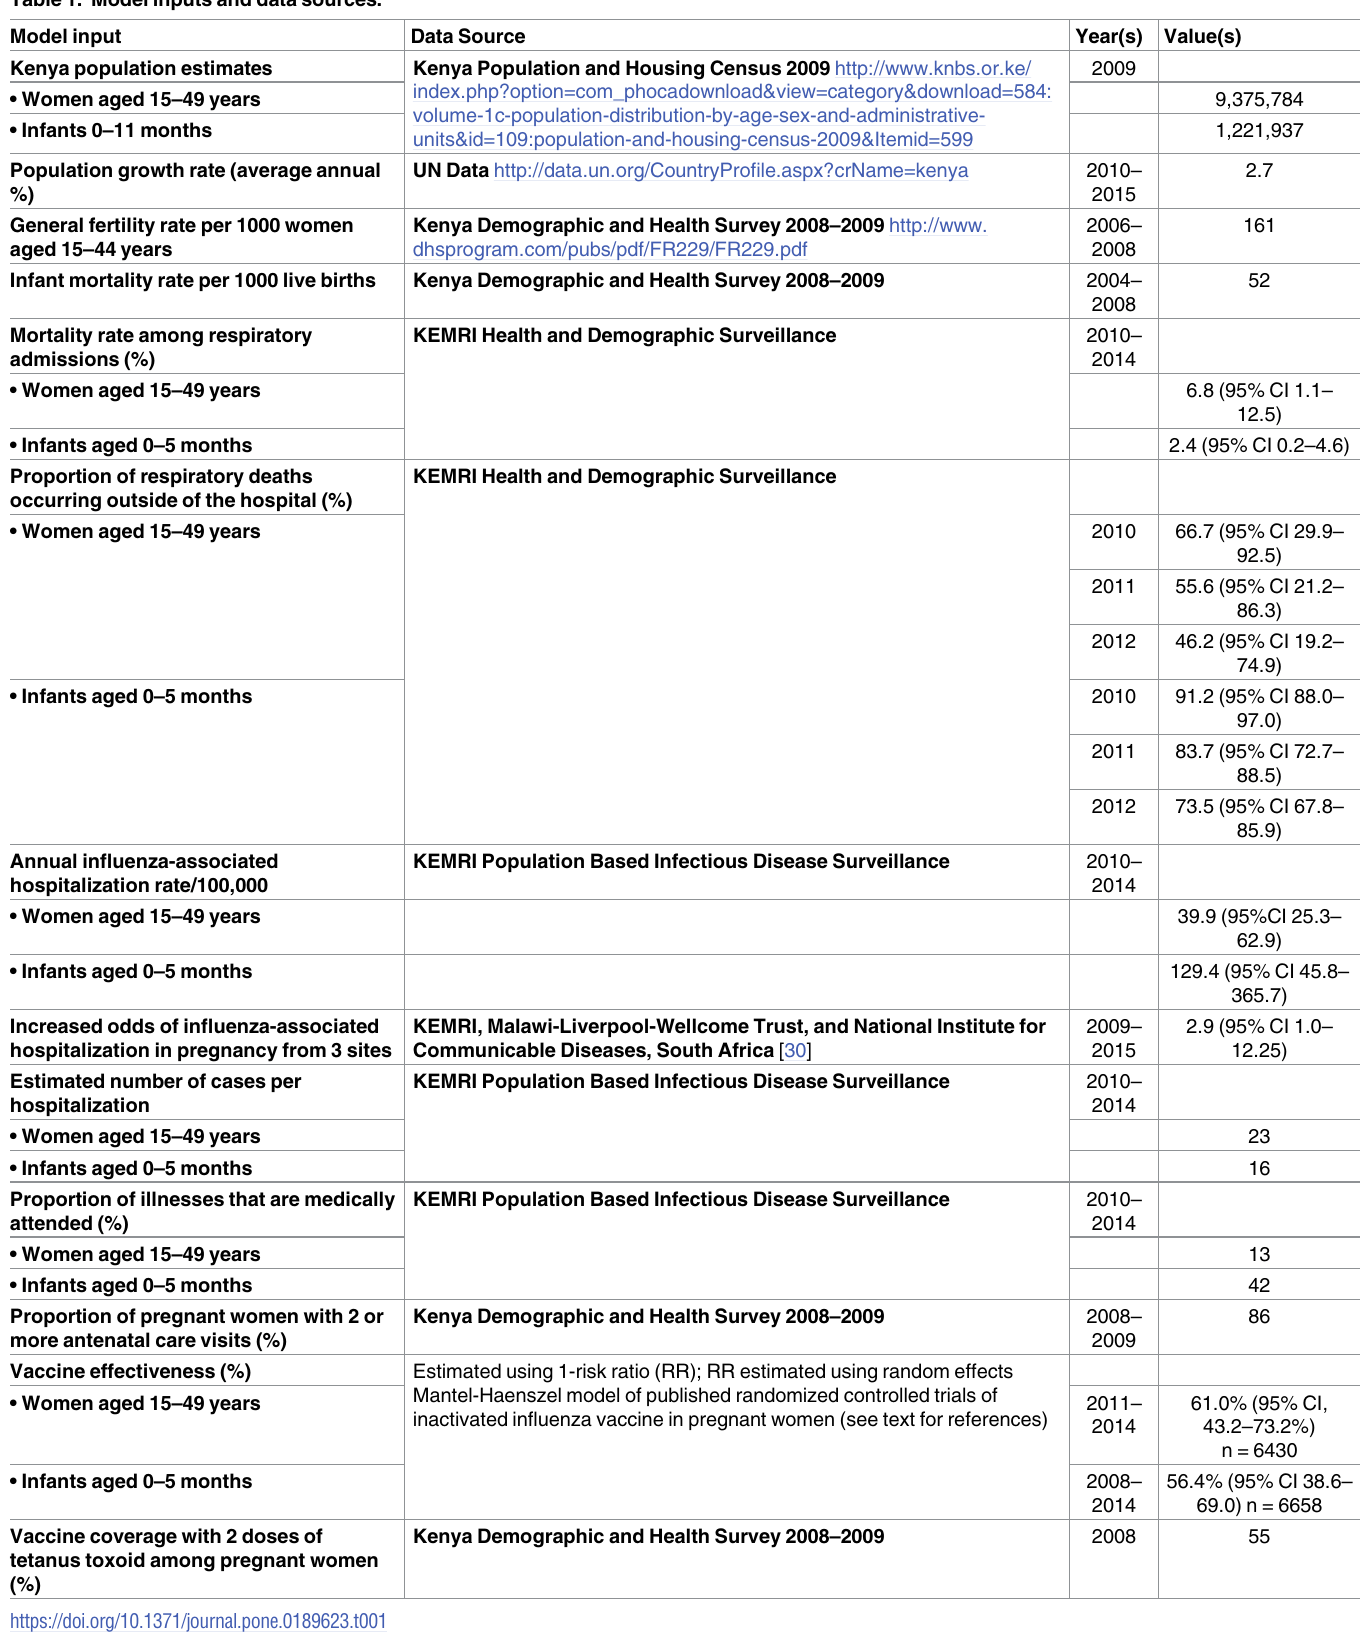
Table 1. Model inputs and data